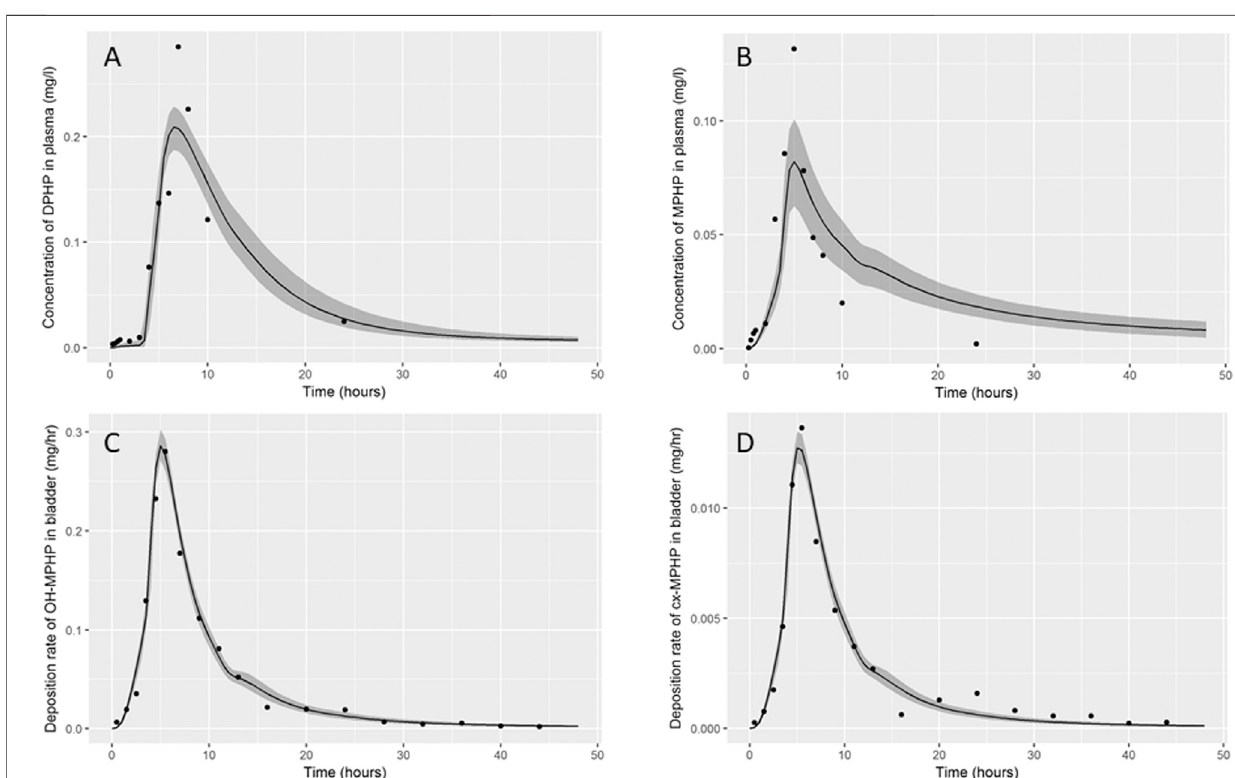
FIGURE 6 | Fit of the calibrated model to data (A) blood DPHP, (B) blood MPHP and urinary excretion of (C) OH-MPHP and (D) _cx-MPHP for volunteer A using global(non-volunteerspeci fi c)andlocal(volunteerspeci fi c)parametersprovidedin Table2 , Table3 ,and Table4 .Thecentralestimatesindicatedinplotscorrespondto the posterior mode whereas the shaded regions represent 95% intervals for the respective curves.